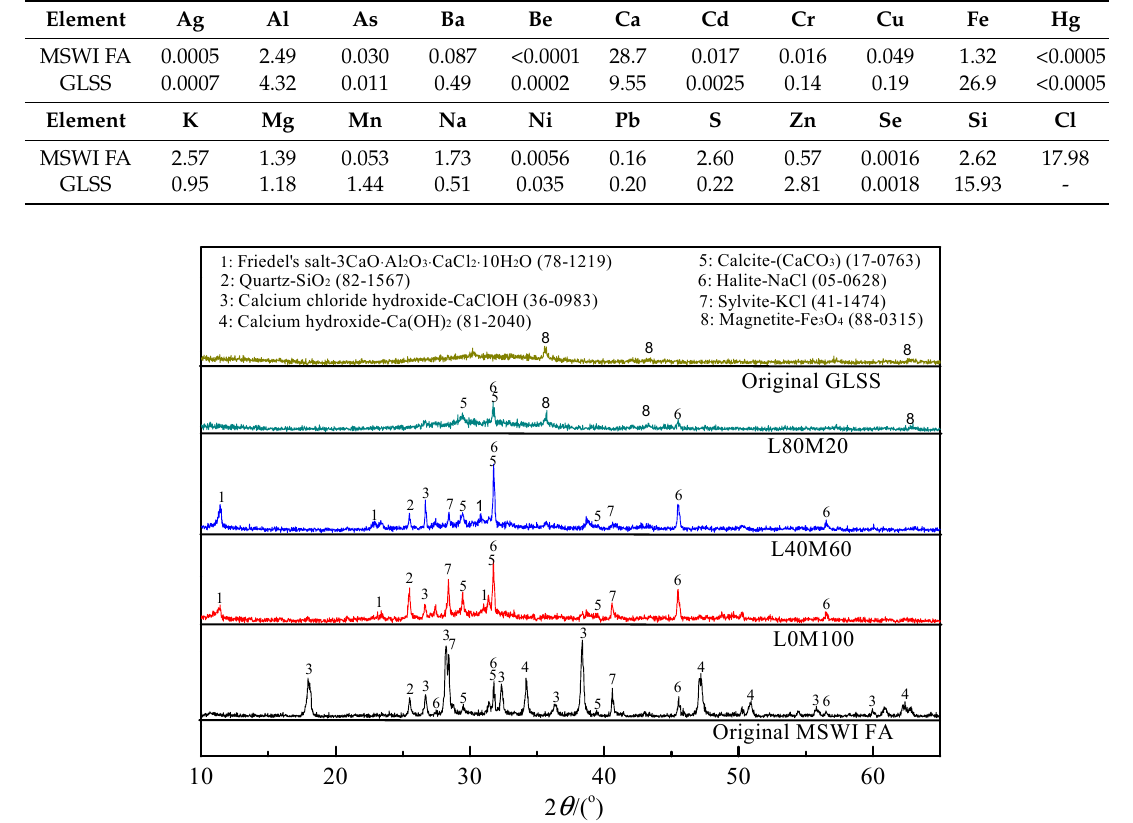
Table 1. Main elemental compositions of the raw materials (wt.%).